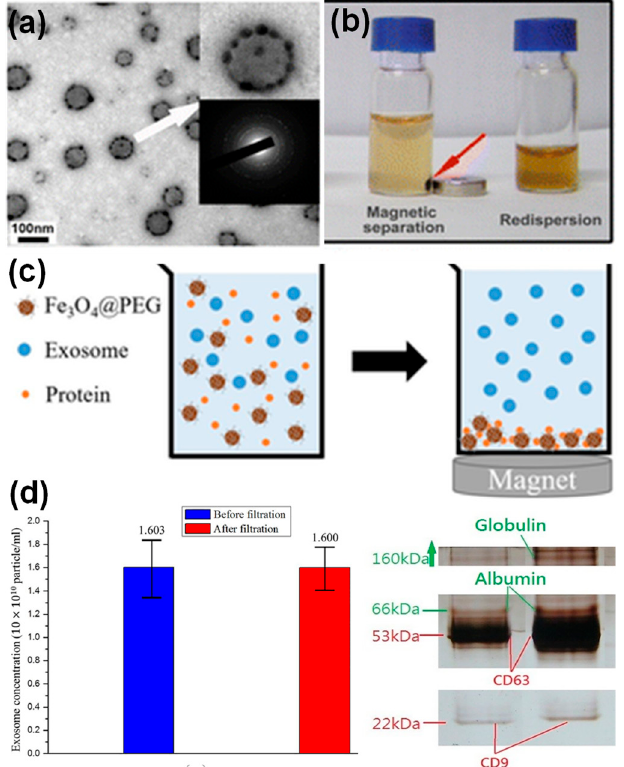
Figure 7. Iron oxide nanoparticles for exosome enrichment: a TEM image ( a ) and magnetic response ( b ) of Tf functionalized iron oxide decorated exosomes from blood serum [51]; PEG functionalized iron oxide nanoparticles for exosome purification: ( c ) principle and ( d ) exosome quantification before and after purification and SDS-PAGE gel of purified exosomes [20].